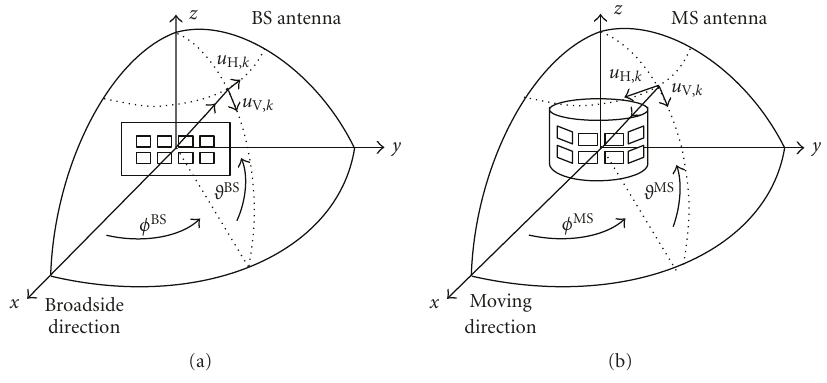
Figure 2: Coordinate systems at the BS and MS.